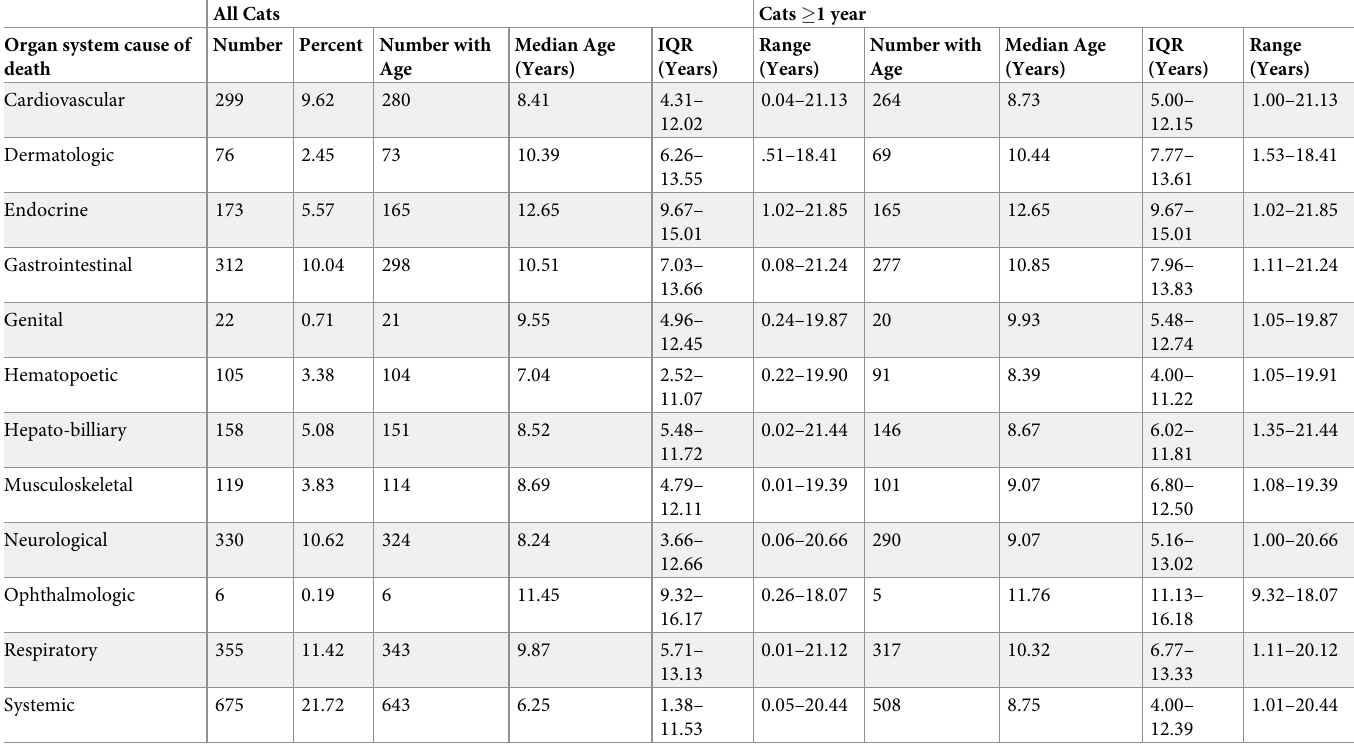
Table 1. Cause of death by organ system, based on necropsy findings, for all cats and for cats � 1 year of age. All Cats